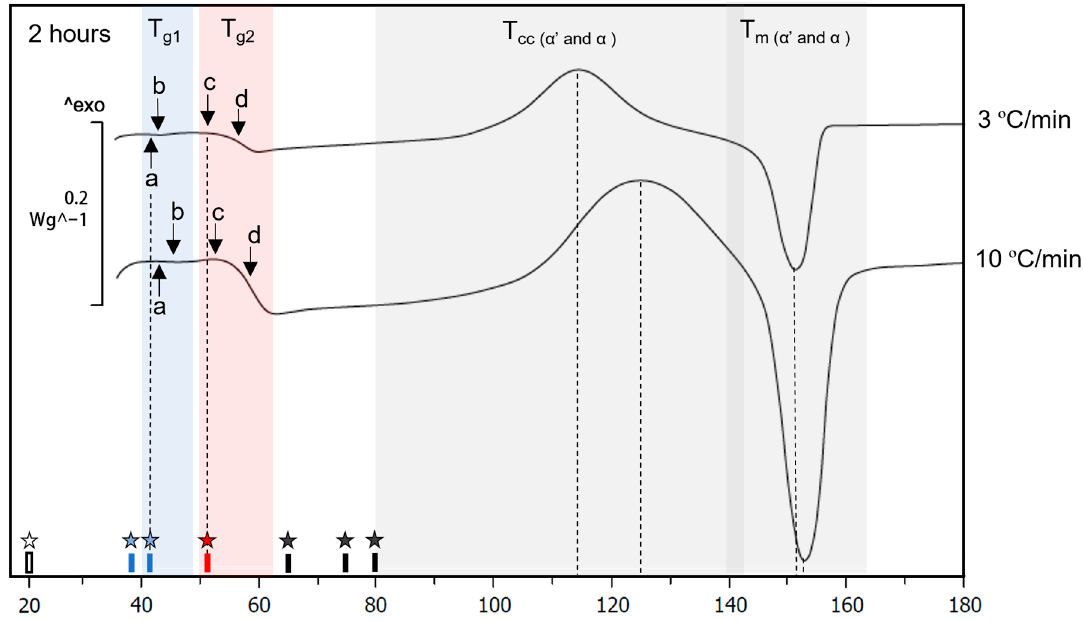
Figure 5. DSC of neat PLA right after printing via FFF at heating rates of 3 and 10 ° C/min. Stars indicate the ageing temperatures used: 20, 39, 42, 51, 65, 75, and 80 ° C. (a) T.onset of the first glass transition; (b) T g of the first glass transition; (c) T.onset of the second glass transition; (d) T g of the second glass transition. Crystallisation and melting reactions are also indicated. Dashed lines are included for reference.